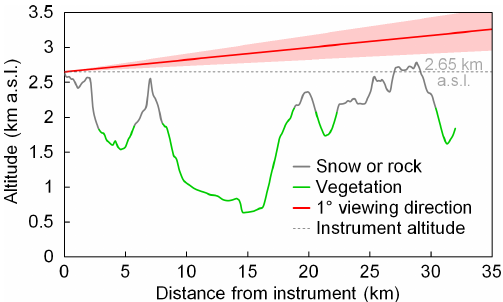
Figure 2. Altitude and type of the ground surface under the view- ing direction (due south) of the MAX-DOAS at the UFS. Both the altitude data and surface type are obtained from Google Earth. The shadow of the line of the 1 ◦ viewing direction indicates the FOV of the telescope which is about 0.98 ◦